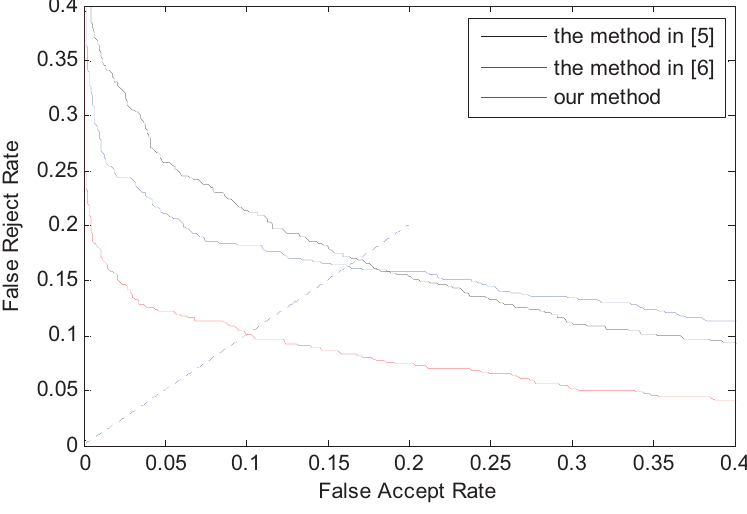
Figure 12. ROC curves on subdatabase by different ROI localization